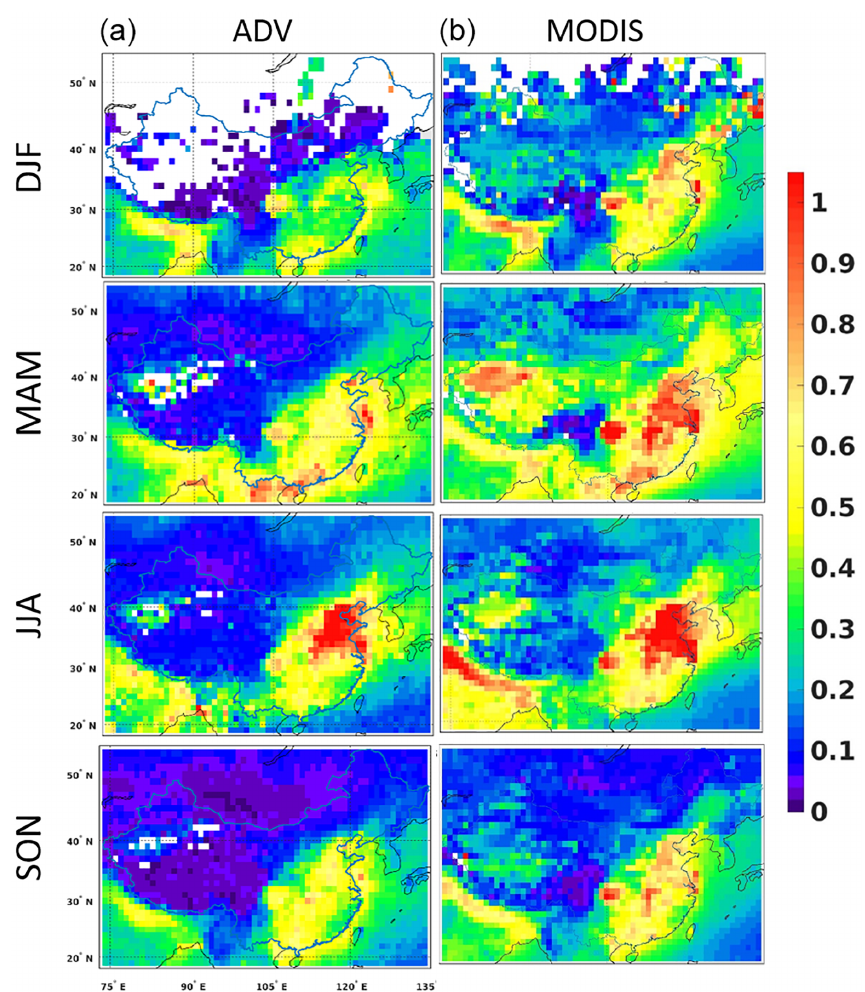
Figure 11. Seasonally averaged maps of the ATSR- (a) and MODIS-retrieved (b) AOD distributions over China for the years 2000–2011: winter (DJF), spring (MAM), summer (JJA) and autumn (SON). The AOD color scale is on the